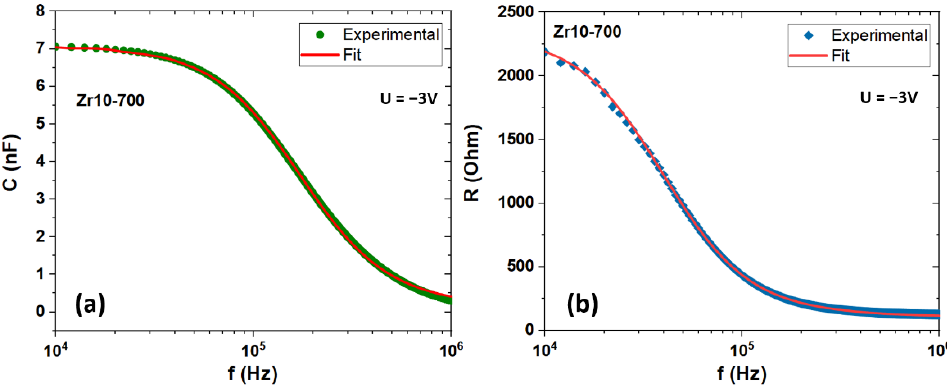
Figure 7. The frequency dependence of the ( a ) capacitance and ( b ) resistance measured on Zr10-700 in the accumulation regime ( − 3 V).